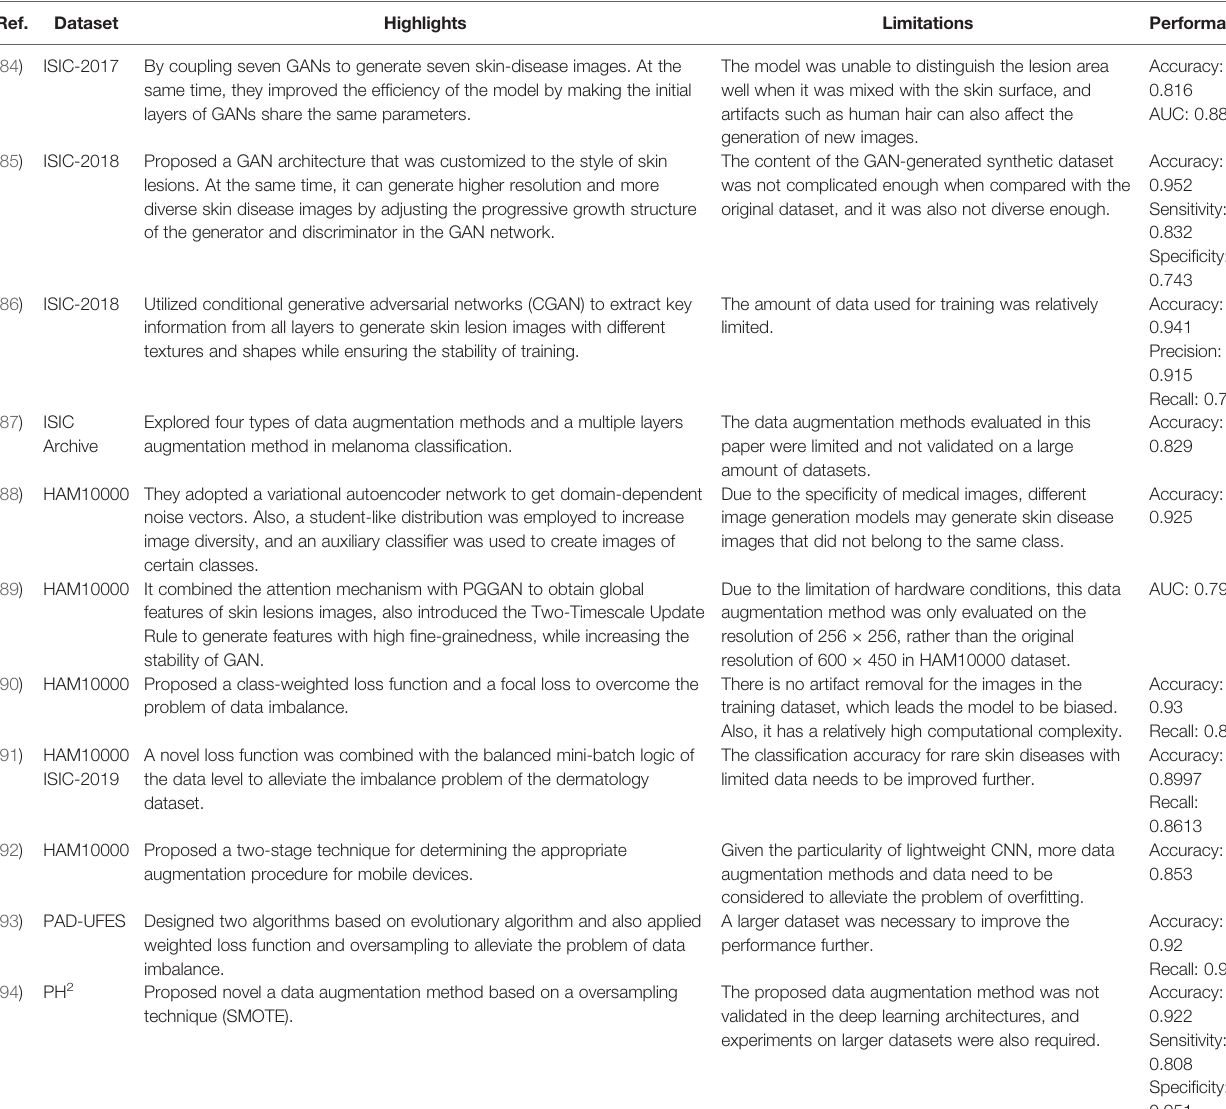
TABLE 4 | Different methods for solving data imbalance and data limitation.